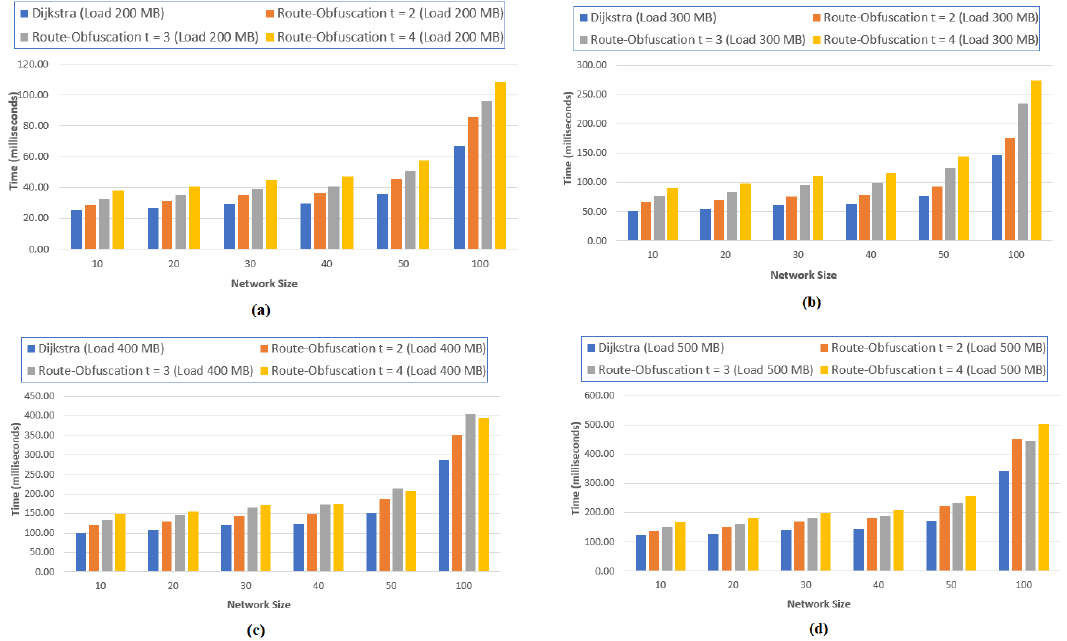
Figure 7. Average execution time of our route obfuscation algorithm. ( a ) Load = 200 MB; ( b ) Load = 300 MB; ( c ) Load = 400 MB; ( d ) Load = 500 MB.